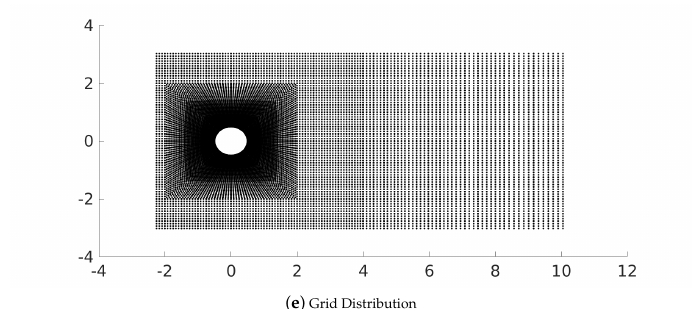
Figure 7. Sensor locations generated using the different methods considered in this work including both random as well as smart algorithms for the cylinder wake flow ( Re = 100). These image show the most relevant 200 sensors, i.e., ( P = 200), while ( e ) represents the grid